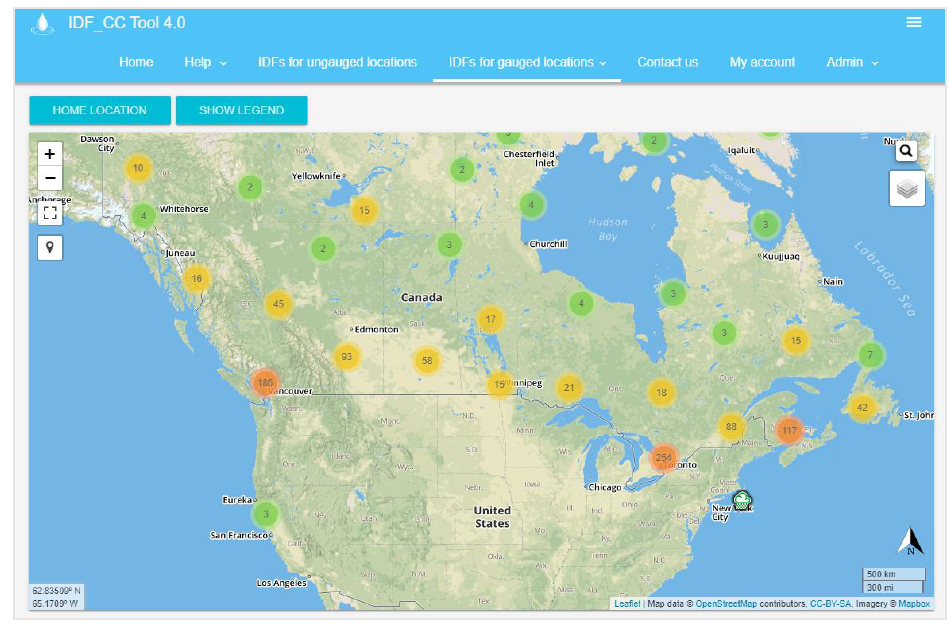
Figure 5. The IDF_CC tool user interface.